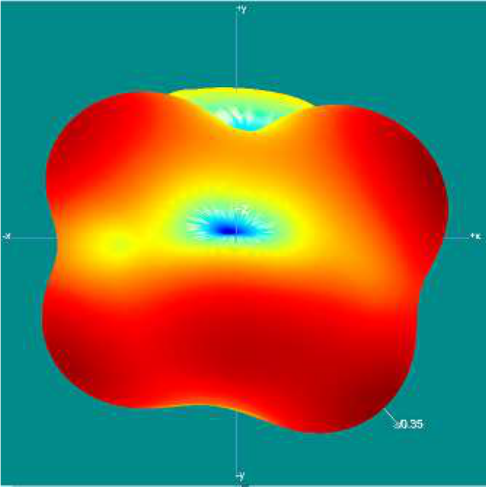
Figure 7 . Measured 3D radiation pattern at 1.70 GHz. Figure 7. Measured 3D radiation pattern at 1.70